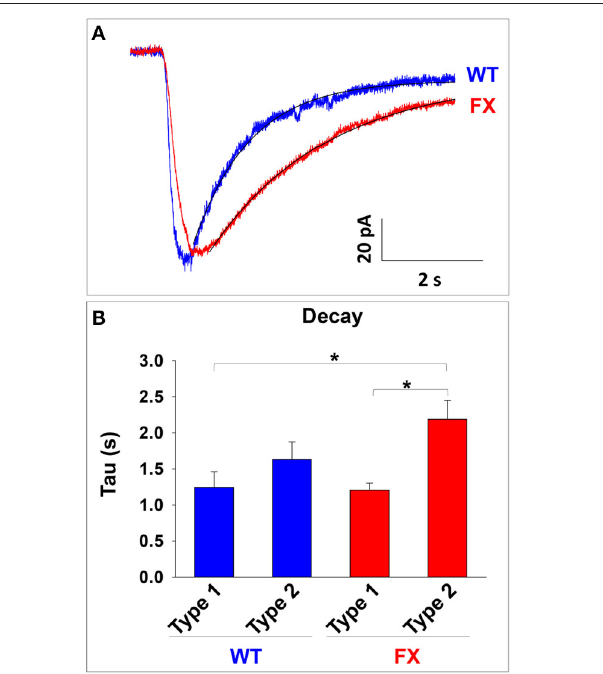
FIGURE 5 | Analysis of GABA response decay in WT and FX neurons. (A) Representative traces of GABA responses and the exponential curve fit used to calculate the value of the decay. A trace from a type 1 response in WT is shown in blue and a trace from a type 2 response in FX is shown in red. Fit curves are shown in black. (B) Measurement of the decay (Tau) in WT and FX neurons, for type 1 and type 2 responses. Values are shown as mean ± SEM. * p < 0.01 ,